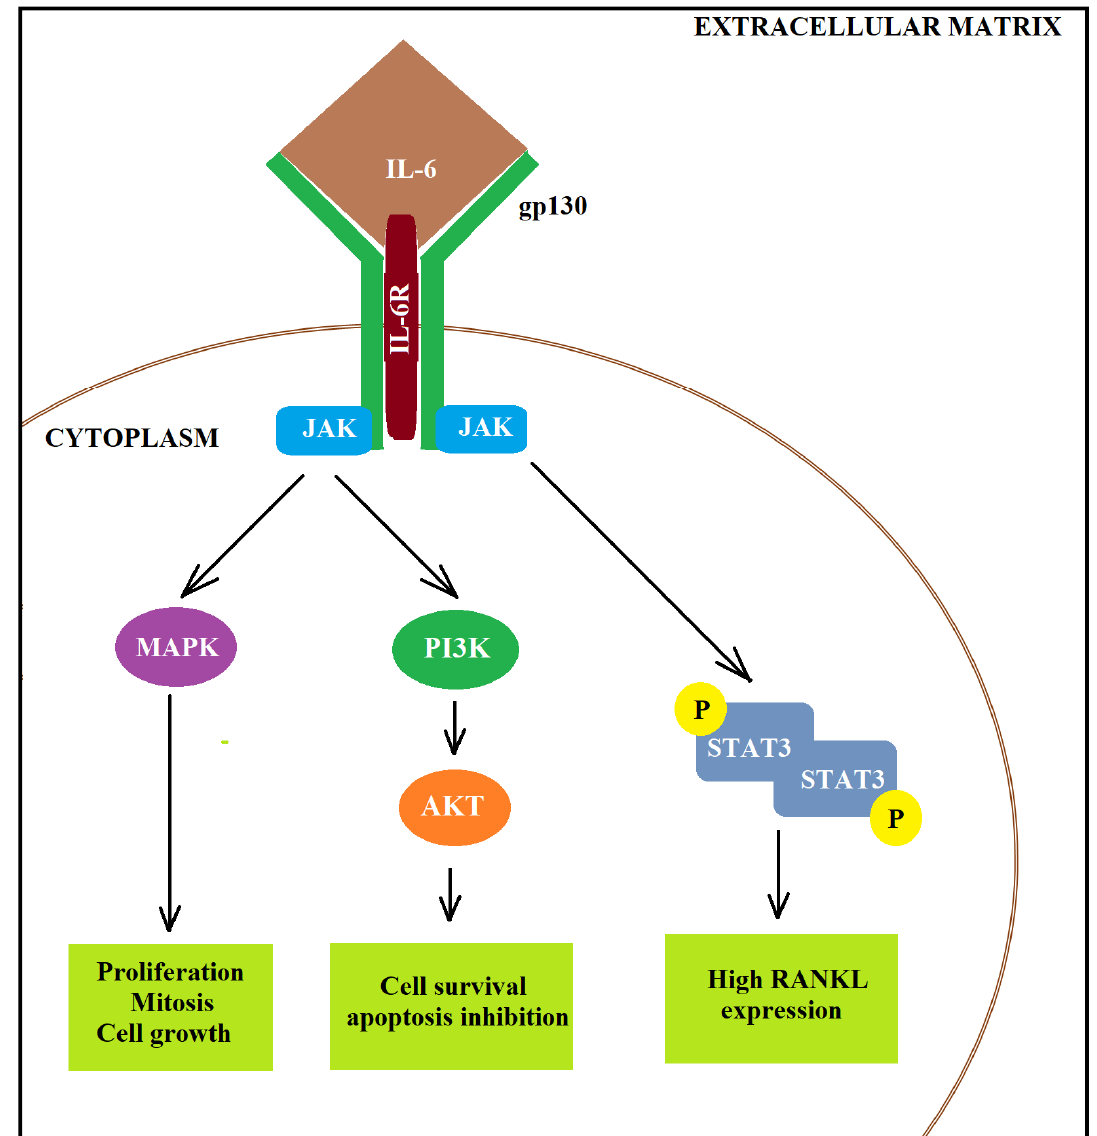
Figure 2. Activation of IL-6 signalling pathway. IL-6 may activate AKT via increased JAK-dependent PI3K activity, causing increased cell survival and anti-apoptosis properties. To this end, firstly, IL-6 binds to the IL6R. Then, the complex binds to the membrane-bound gp130 dimer to form an IL-6 trans-signalling complex and activates (i) the JAK-dependent MAPK, (ii) the JAK-dependent PI3K or (iii) the JAK-dependent STAT3.